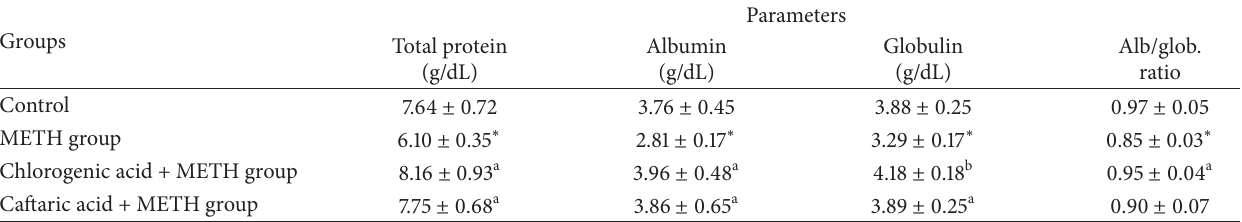
Table 2: Effect of chlorogenic and caftaric acids on serum total protein, albumin, globulin, and albumin/globulin ratio of METH-injected rats.